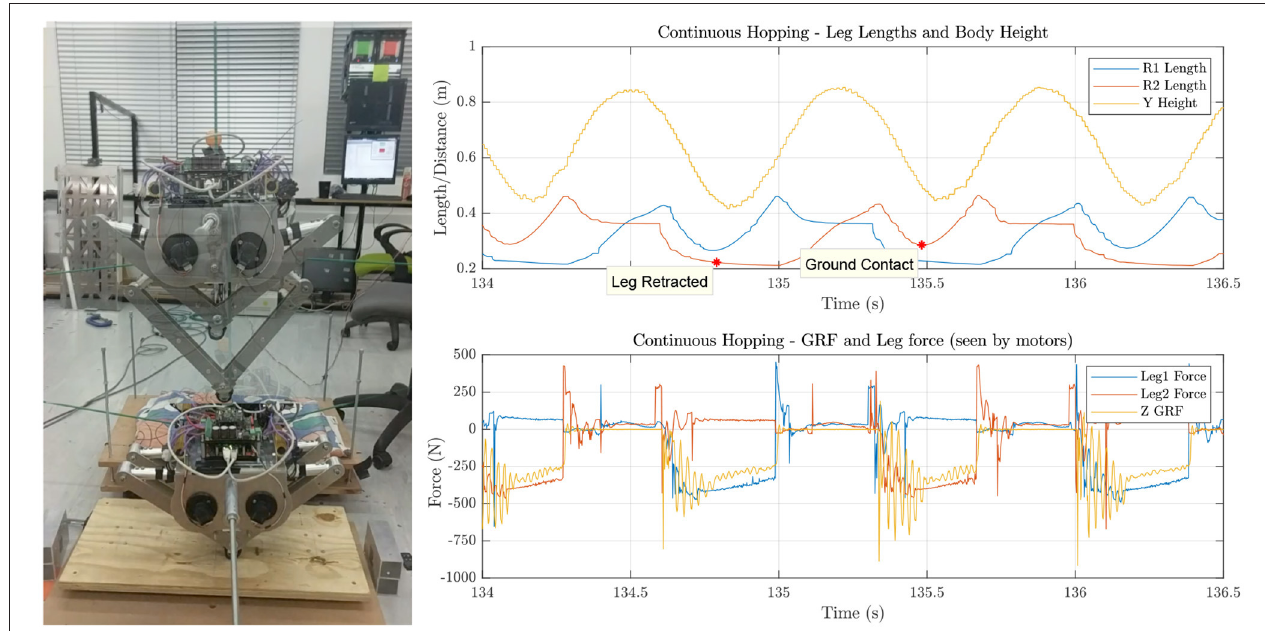
FIGURE 9 | Baleka can be seen hopping on the left with the resultant ground reaction forces (proprioceptive and actual force) and leg lengths revealed on the graph on the right.